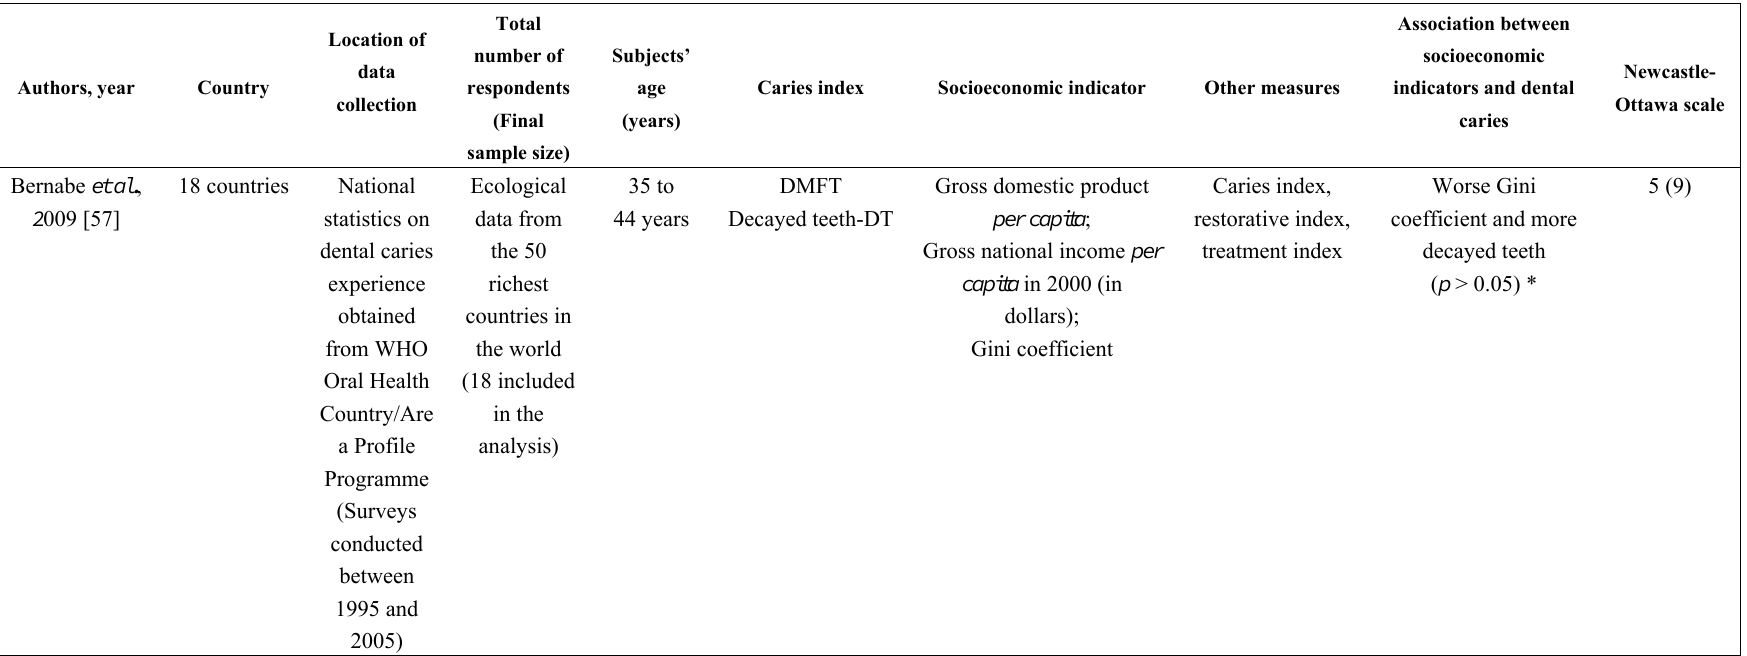
Table 3. Study characteristics and results from ecological